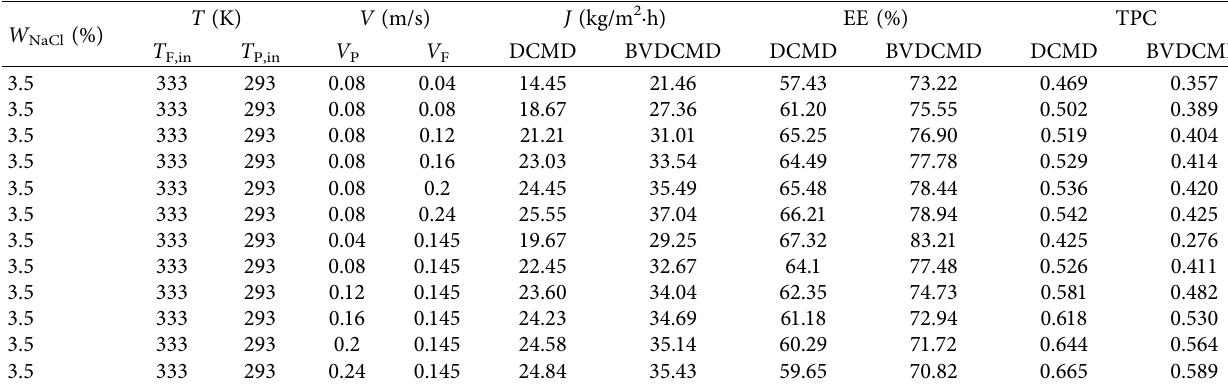
Figure 13: Permeate flux under different inlet velocity of the permeate side. T P P � 3400Pa, W NaCl � 3.5%.